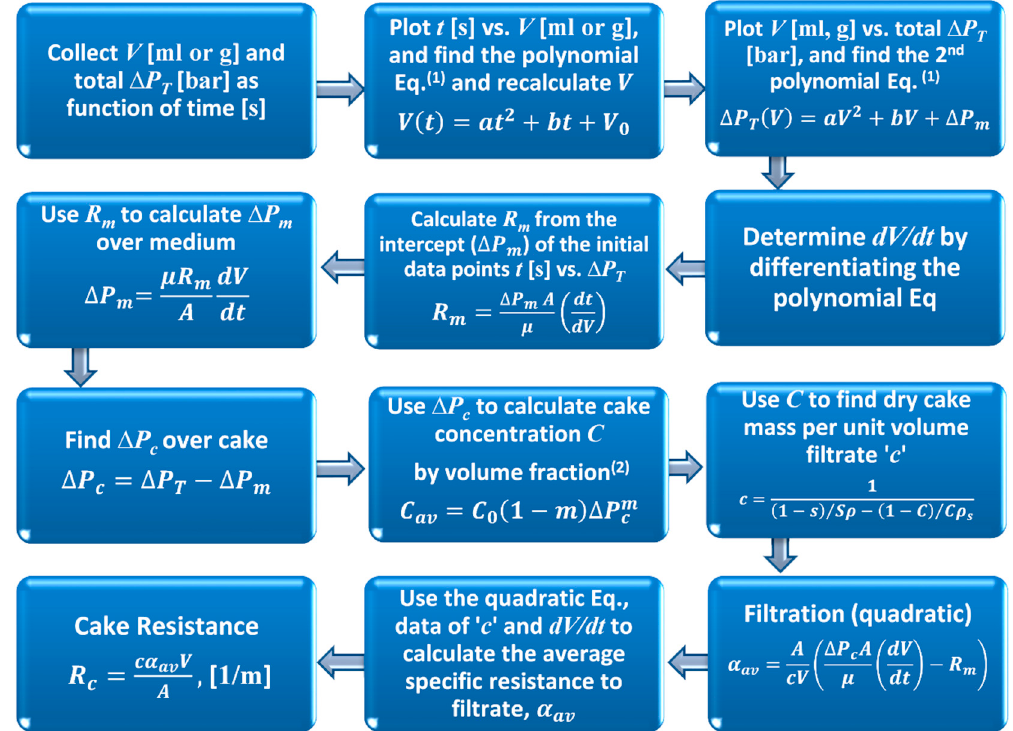
Figure 3. The Flow chart of calculation steps for the constant rate filtration (CRF) technique to determine specific resistance. (1) Parameters: a , b are fit constants, t is the process time, V is the filtrate volume, ∆ P m is the membrane and ∆ P c is the pressure over the cake. Also used in analysis, μ is the liquid viscosity, A the cake surface area, R m the membrane resistance, R c the total cake resistance and α av the average specific cake resistance. Initial data points (e.g., stage 1 in Figure 5) which are used to calculate R m , should not be included in the overall data trendline, except in the case of an incompressible material. (2) A series runs at different pressure are required in order to calculate C 0 and m .